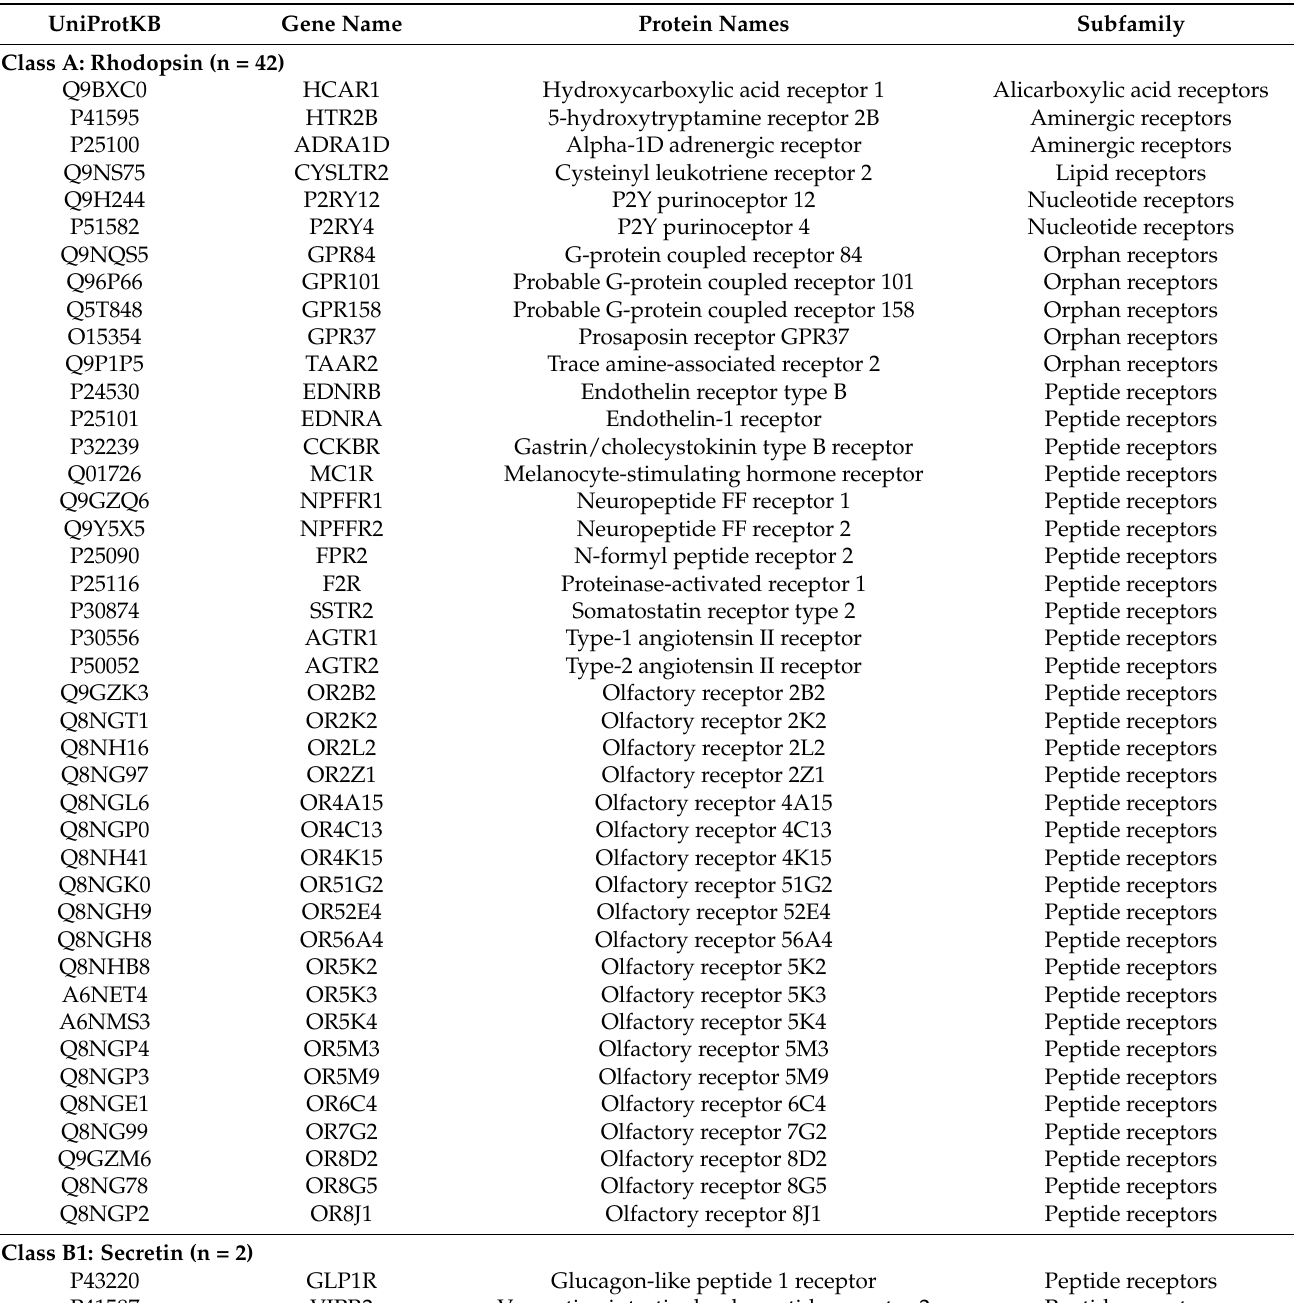
Table 1. G-protein coupled receptors (GPCRs) identified in human spermatozoa. The sperm GPCRs were divided into families, and the subfamily for each receptor is indicated according to the